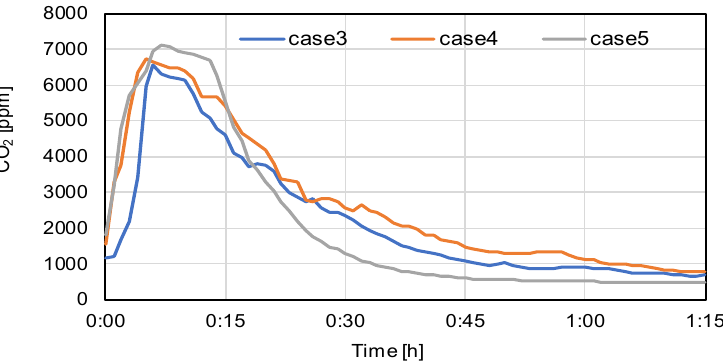
Figure 4. Carbon dioxide concentrations with a ventilation fan and natural ventilation (conditions 3–5).